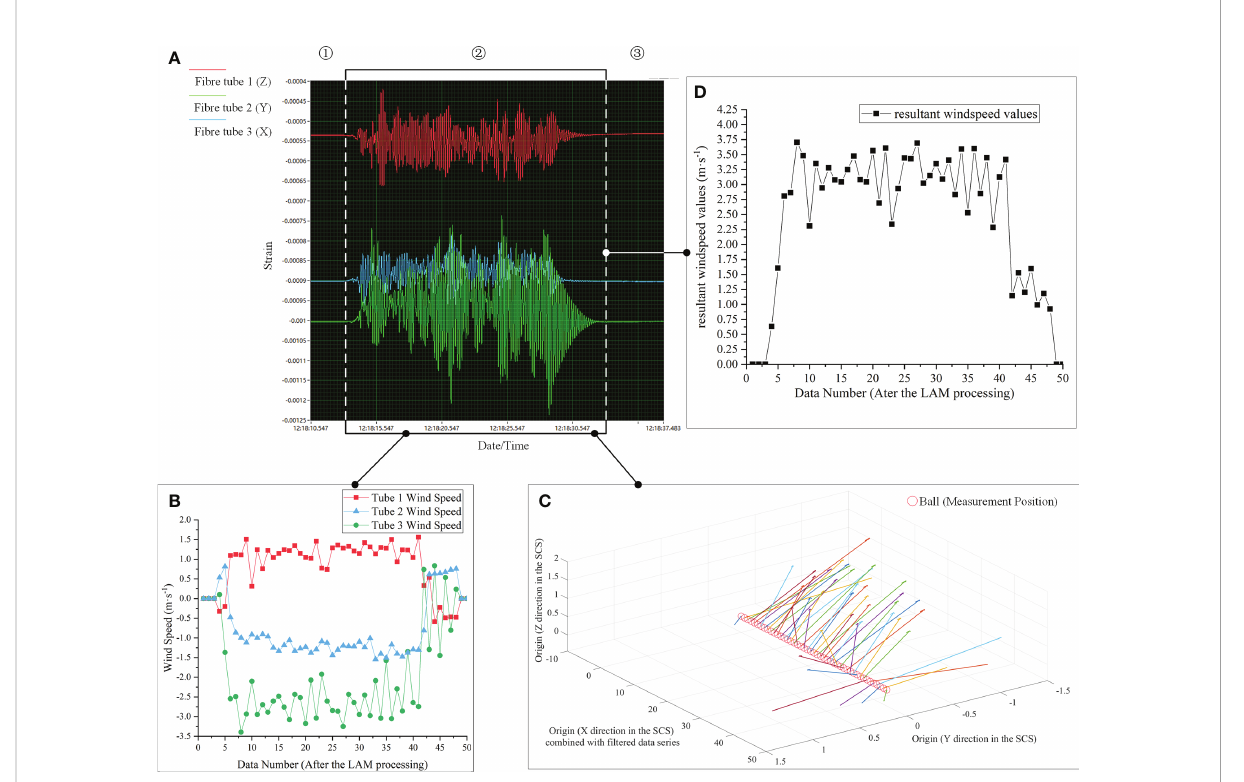
FIGURE 12 The result of measurement of the wind among tree canopies, where (A) is the strains measured by the system, (B) shows the wind speed of each SCS direction after the LAM processing, (C) illustrates the wind vector variations based on the LAM-processed data series, and (D) gives the resultant wind speed values based on each direction results shown in (B)